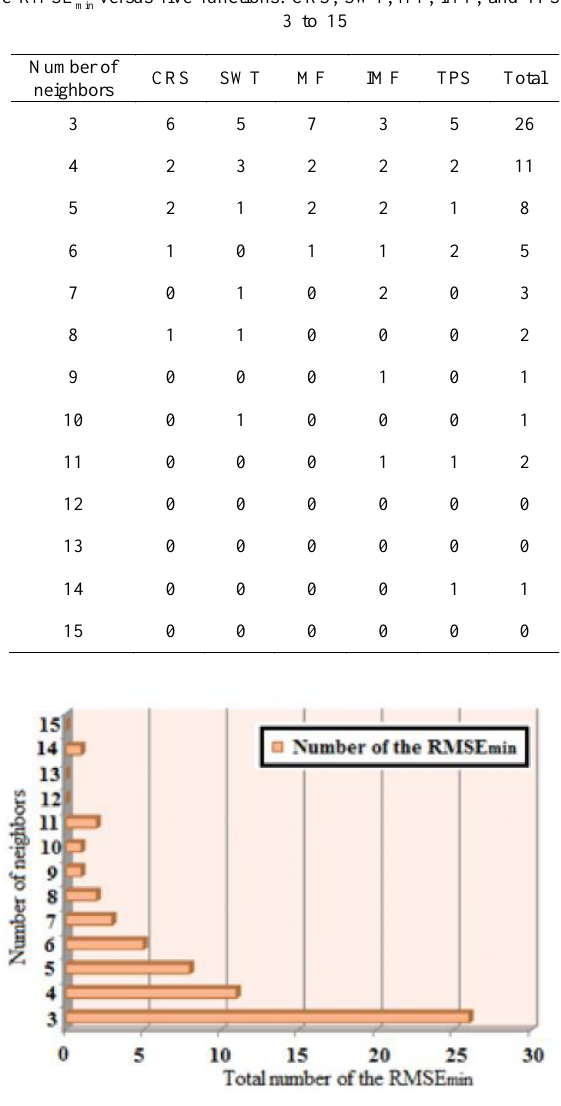
Fig. 3: Results of the RMSE assessment with considering number of neighbors and total number of the RMSE min of functions, including CRS, SWT, MF, IMF, and